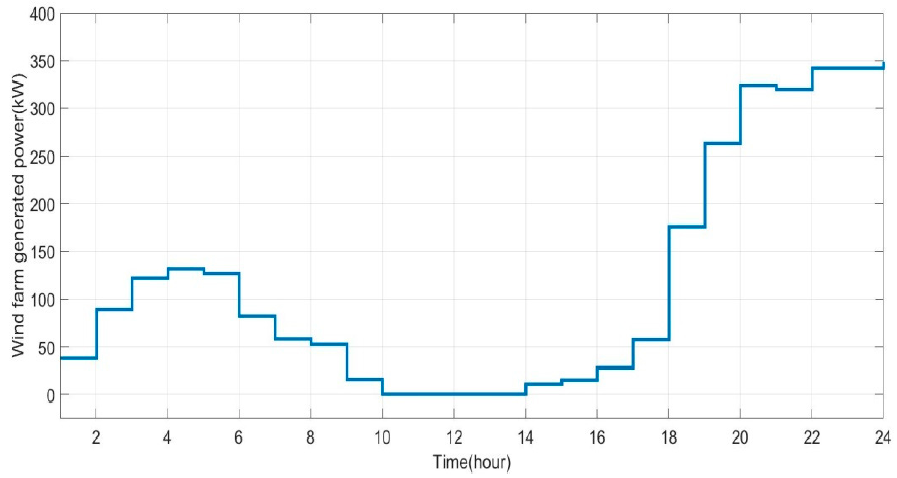
Figure 6. Output power of the wind farm in scenario 10.